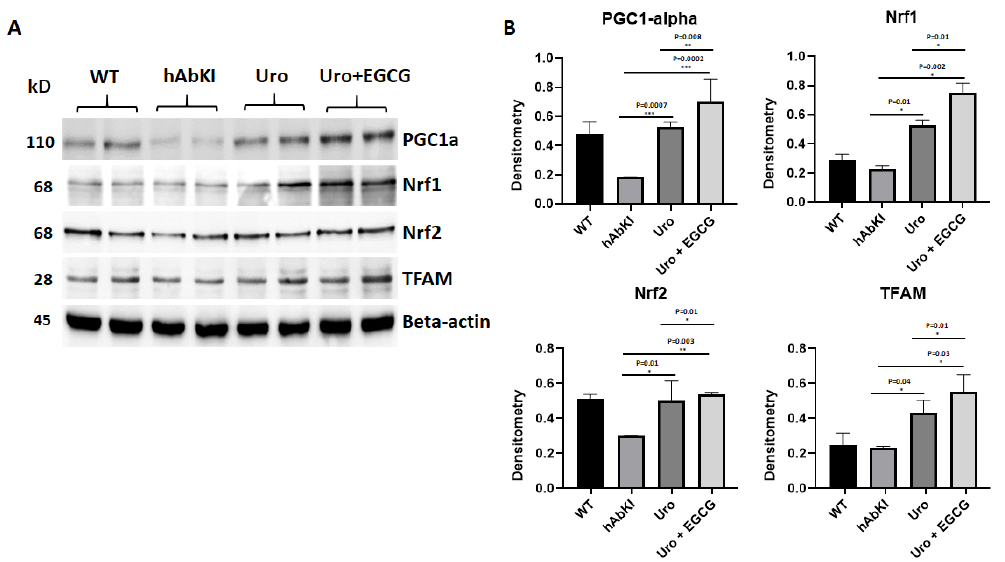
Figure 4. Immunoblotting analysis of mitochondrial biogenesis. ( A ) Representative immunoblots for mitochondrial biogenesis proteins in hAbKI mice and treated hAbKI mice with Urolithin A and EGCG. ( B ) Quantitative-densitometry analysis of mitochondrial biogenesis proteins PGC1 α , NRF1, NRF2 and TFAM. PGC1 α , NRF1, NRF2 and TFAM were significantly increased in the treated hAbKI mice Urolithin A and